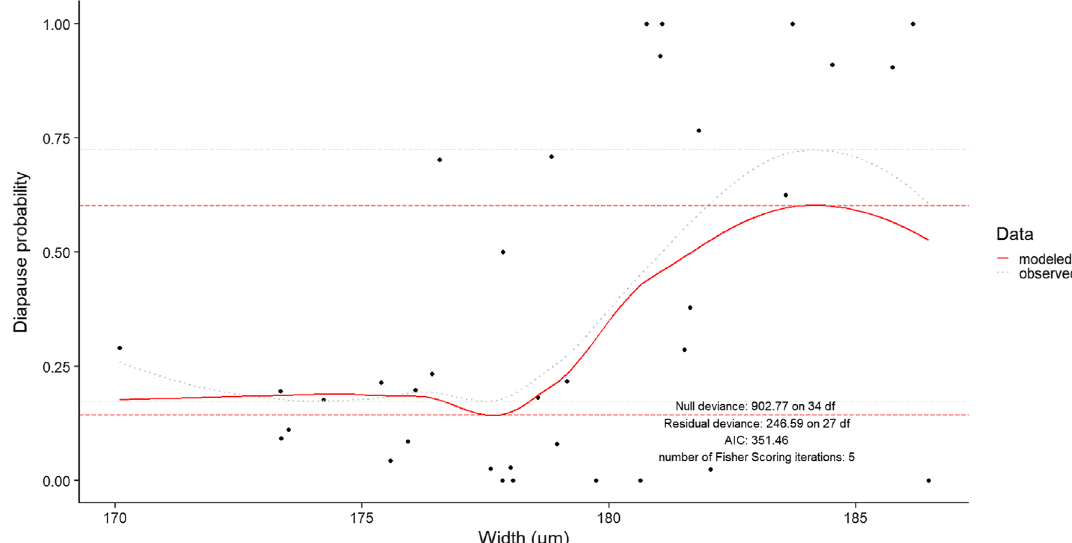
Figure 7. Field data and predicted model of diapause probability. Data come from the Reichstett fi eld area. Mean per week is shown in black dots. Grey dotted line is the associated curve trend. A logistic model of regression, considering week of collection, year and width of eggs is shown with a solid red line. Diapause incidence is in both cases higher when width measurements increase. Minimum and maximum values of observed diapause probability and predicted diapause probability are highlighted in horizontal long dashed lines, in grey and red, respectively. Model estimators are directly written on the